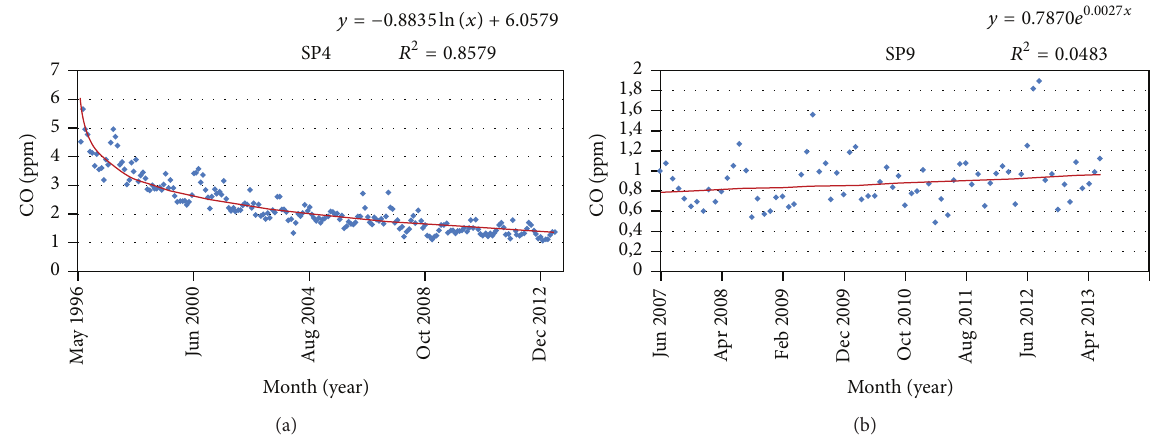
Figure 2: Scatter plot of monthly averages for stations (a) SP4 and (b) SP9. Red dotted line in the trend line follows the function 𝑦 and 𝑅 2 is the coefficient of